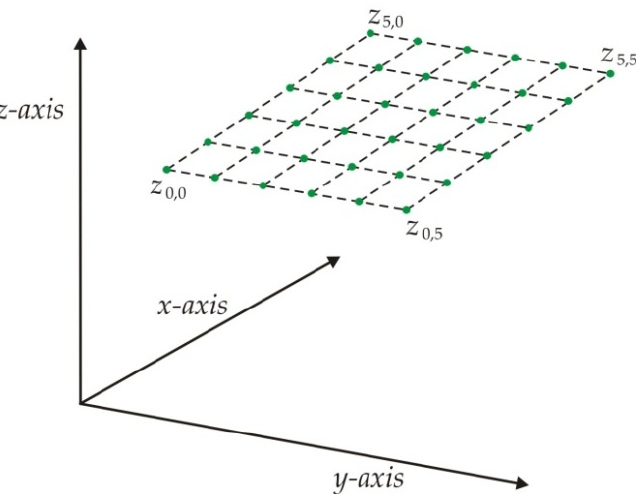
Figure 3. Surface coordinates to perform flat surface modeling.